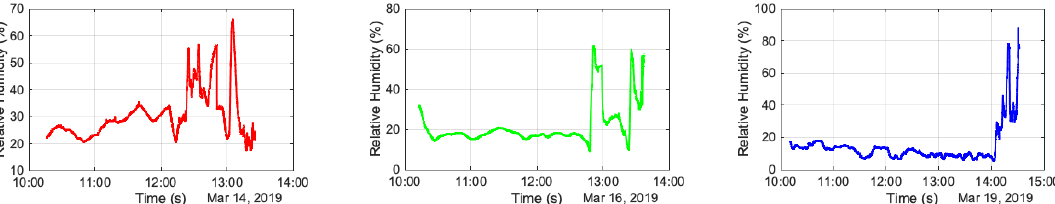
Figure A3. The atmospheric temperature on each observation day during flight.